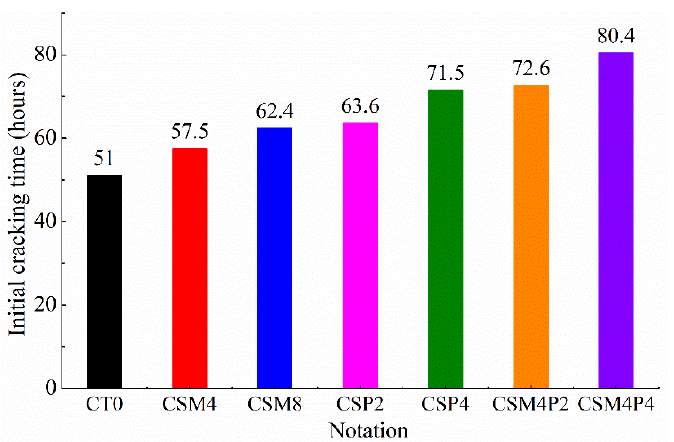
Figure 6. The initial cracking time of hydraulic concretes added with MgO and/or PVA